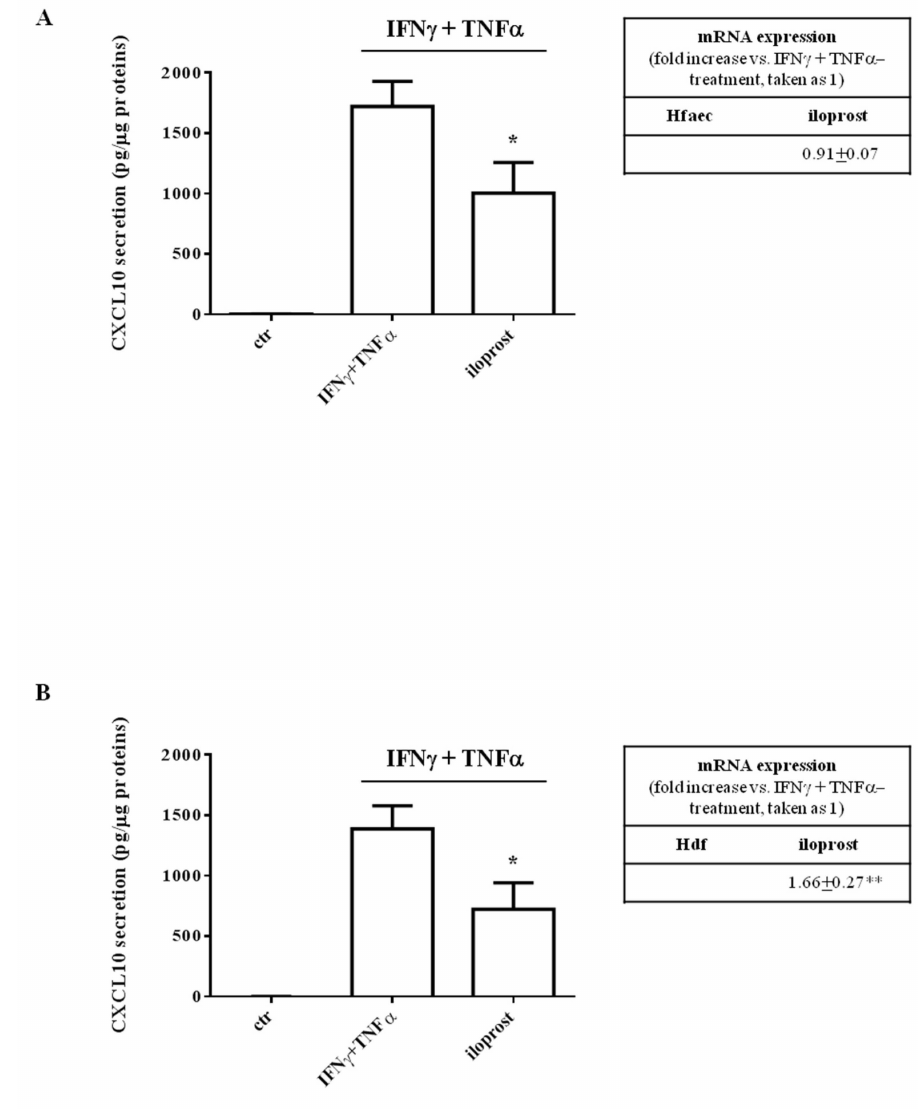
Figure 1. Iloprost-induced decrease of CXCL10 protein secretion in supernatants from cytokine- activated human endothelial cells (Hfaec) and dermal fibroblasts (Hdf). ( A ) In Hfaec, iloprost inhibited cytokine-induced CXCL10 release (* p < 0.05 vs. IFN γ and TNF α -induced secretion), without modifying chemokine-specific mRNA expression (inset of ( A )). ( B ) In Hdf, iloprost reduced cytokine-induced CXCL10 release (* p < 0.05 vs. IFN γ and TNF α -induced secretion) and increased CXCL10 mRNA expression (inset of ( B )) (** p < 0.01). Chemokine secretion is expressed as pg/ µ g of total proteins (mean ± SE). Data were obtained from five experiments with different cell preparations. mRNA expression is reported as a fold increase with respect to IFN γ and TNF α -induced expression, taken as 1. Data were obtained from three experiments with different cell preparations and reported as mean ±